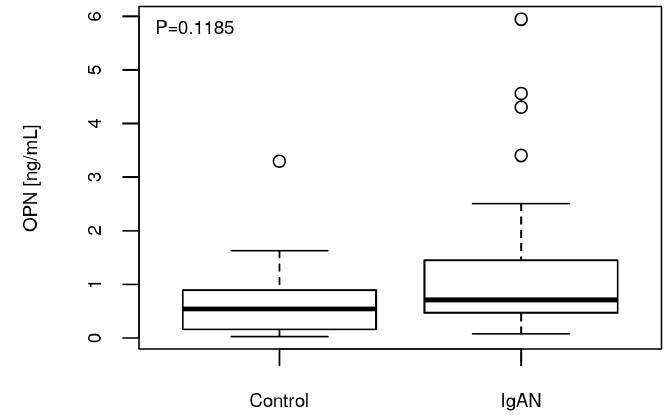
Figure 1. Comparison of median urinary osteopontin (OPN) levels between immunoglobulin A nephropathy (IgAN) patients (N = 58) and controls (N = 19).